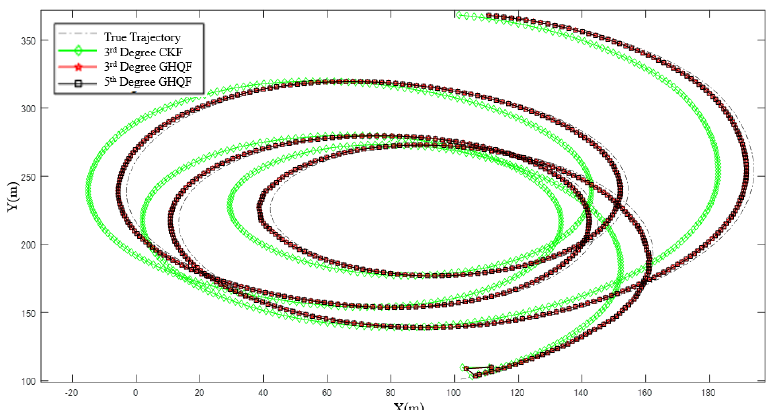
Figure 13. Experimental RFI emitter-tracking based on TDOA/FDOA measurements: Results of CKF